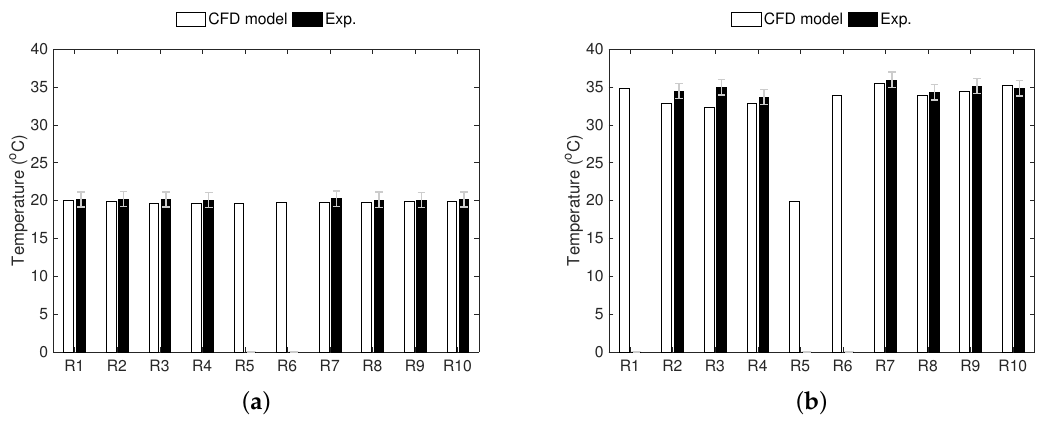
Figure 6. Temperatures at ( a ) the front side and ( b ) the back side of the server racks. RSM is used as turbulence model in the CFD